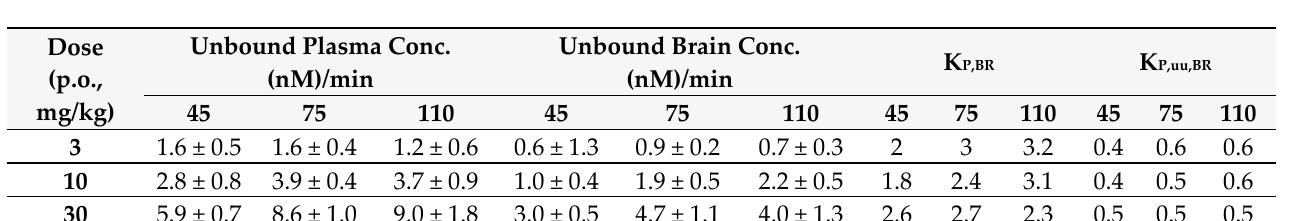
Figure 4. Effect of a single administration of HC-070 (mg/kg, p.o.) on injured paw mechanical hypersensitivity in the rat model of peripheral neuropathic pain (chronic constriction injury, CCI). ( A ) Results of the withdrawal threshold (g) evoked by the paw pressure test are expressed as the mean, the error bars represent SD, n = 10/treatment group. Two symbols indicates treatment p < 0.01, three symbols p < 0.001, as compared to the control paw of the corresponding group, Dunnett’s test after significant two-way ANOVA or the Wilcoxon matched-pairs signed rank test. * p < 0.05, *** p < 0.001, as compared to the vehicle-treated CCI group, Dunnett’s test after significant two-way repeated measures ANOVA or Dunn’s test after a significant Kruskal–Wallis test. ( B ) Results of reversal percentage (%) are expressed as the mean, the error bars represent SD, n = 10/treatment group, and each symbol represents an individual data point. Dashed line illustrates the level of